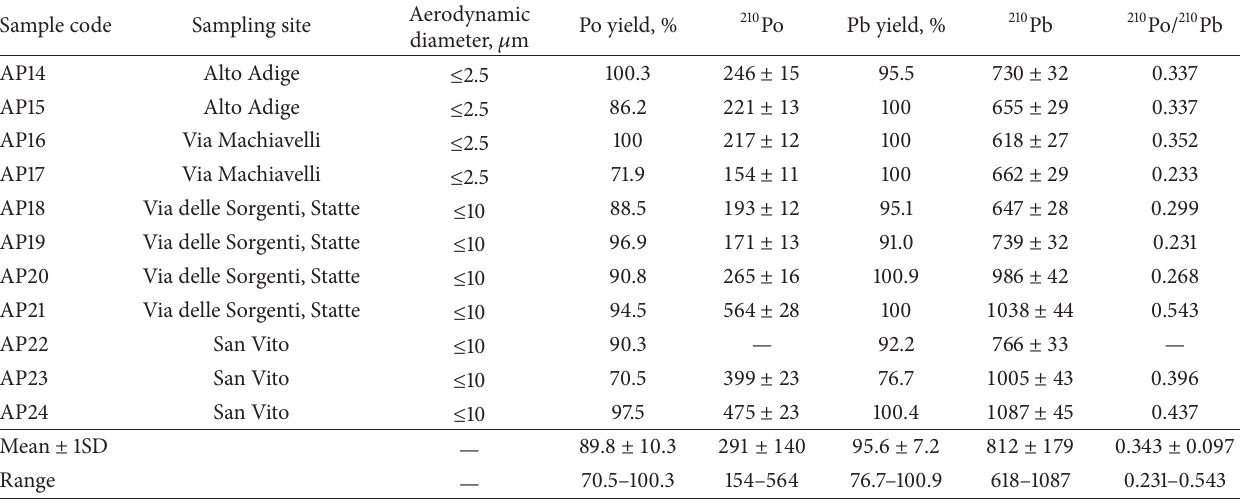
Table 11: The 210 Po and 210 Pb concentrations in 𝜇 Bqm − 3 in atmospheric particulate (AP) collected from the area of the ILVA Taranto on 4–12 May